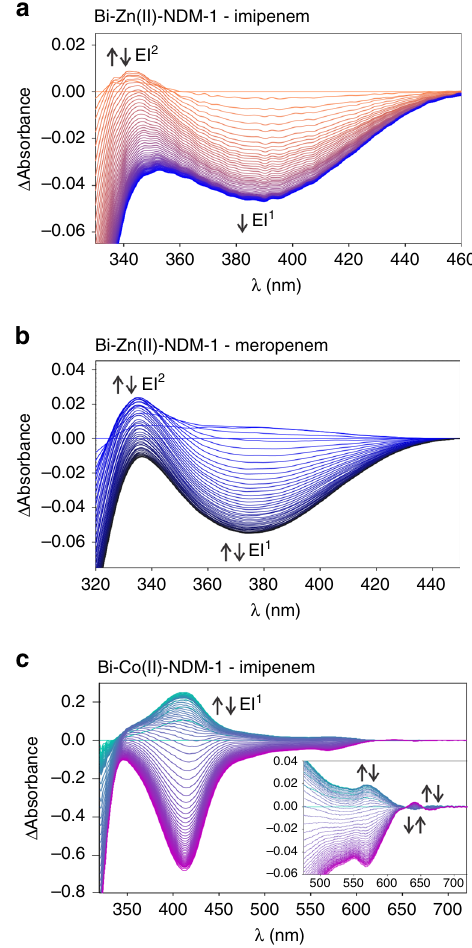
Fig. 4 Electronic absorption spectra of carbapenem hydrolysis catalysed by binuclear M β Ls. a Sequence of difference spectra upon the reaction of 150 μ M imipenem and 95 μ M bi-Zn(II)-NDM-1. The reaction progresses from orange to blue spectra. The time interval covers from 0.002 to 0.07 s. b Sequence of difference spectra upon the reaction of 100 µ M meropenem and 100 μ M bi-Zn(II)-NDM-1. The reaction progresses from blue to black spectra. The time interval covers from 0.002 to 0.05 s. c Sequence of difference spectra upon the reaction of 450 µ M imipenem and 112.5 μ M bi-Co(II)-NDM-1. The reaction progresses from green to purple spectra. The time interval covers from 0.002 to 0.67 s. The inset shows a magni fi cation of the 450 – 720 nm